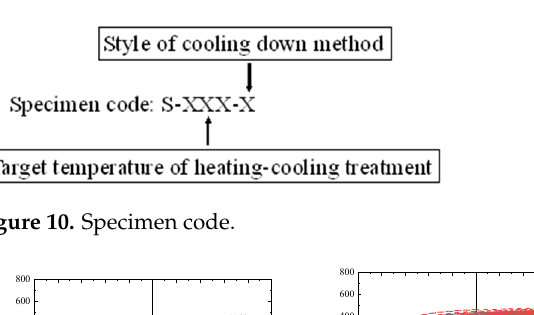
( b ) Figure 8. Ultimate strength residual factor. ( a ) Q235 and Q345; ( b ) S304 and S316. 3.1.4. Fracture Strength The post ‐ fire fracture strengths of all four types of structural steels were decreased compared to their corresponding ultimate strengths without fire influence, and the fracture strength drop ratios ( D fu1 ) were defined as ( f u − f u1 )/ f u , as shown in Figure 9a,b. It can be found that all the fracture strength drop ratios were larger than 15%, which is the limit of the seismic design requirements [11]. This meant that the tested structural steels still exhibited good seismic ductility after exposure to heating–cooling processes. Moreover, the influence of steel grades on the fracture strength drop ratios was more significant than the target temperatures and cooling ‐ down methods of heating–cooling treatments discussed in this paper. ( a ) ( b ) Figure 9. Fracture strength drop ratio. ( a ) Q235 and Q345; ( b ) S304 and S316.